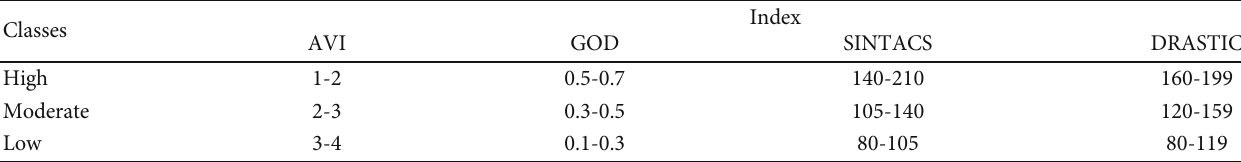
Table 12: Values of the respective classes for each method.